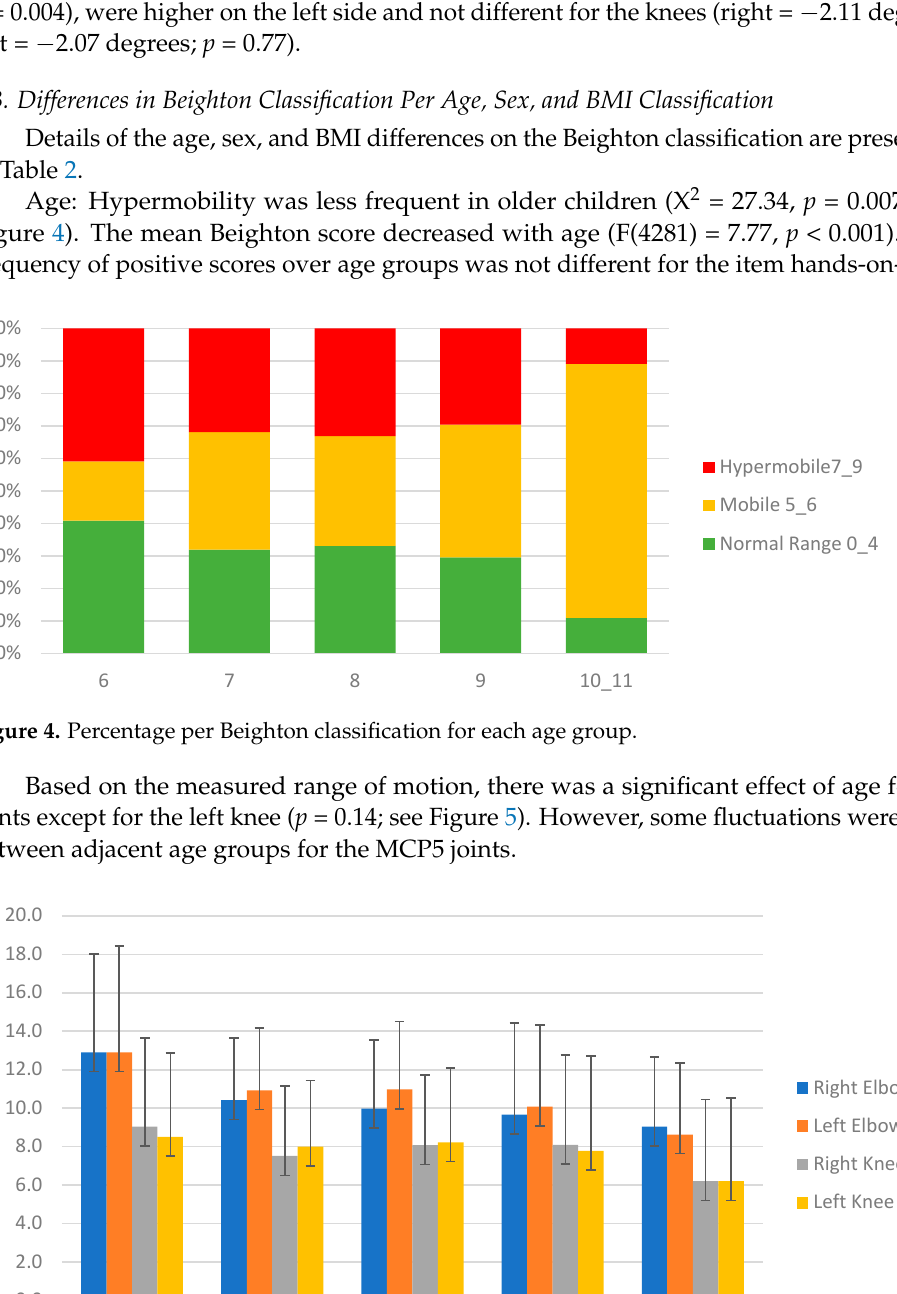
Figure 5. Range of motion in the age groups based on goniometry. Sex: The mean total Beighton score was 5.04 (SD1.67) and 5.64 (SD1.82) for boys and girls, respectively (t(1284) = − 2.94, p = 0.004). Of the girls in our sample, 34% were classified hypermobile (score 7–9) while this was 20% for the boys. Females were more often rated hypermobile on the di ff erent Beighton items and the chi-square showed a higher fre- quency of positive scores for the left elbow ( Χ ² = 5.98. p = 0.015), and left ( Χ ² = 11.22, p = 0.001) and right knee ( Χ ² = 7.91, p = 0.006). One item showed a trend in the opposite direc- tion; boys were more often (16.7%) able to put their hands fl at on the ground than the girls (9.5%; Χ ² = 3.29. p = 0.08). Based on the measured degrees of RoM, there was a signi fi cant e ff ect of gender for the knees (right (t(1284) = − 2.06, p = 0.04); left (t(1284) = − 3.26, p = 0.001) and not for the MCP5 and elbows. BMI: Di ff erences emerged in Beighton scores between BMI classi fi cation groups, but the pa tt ern of di ff erences was not comparable between joints. Frequencies of positive scores were di ff erent for the knee ( Χ ² = 8.54, p = 0.014) and thumb item on the right ( Χ ² = 8.68, p = 0.013). Goniometry showed that all except one joint were di ff erent (elbow right; p = 0.21) for the BMI classi fi cation groups (all p < 0.02), however, the direction di ff ered per joint (Figure 6). The li tt le fi ngers showed a larger RoM in obese/overweight children, while the knees were more mobile in underweight children. The elbows were the least mobile in the nor- mal-weight children.